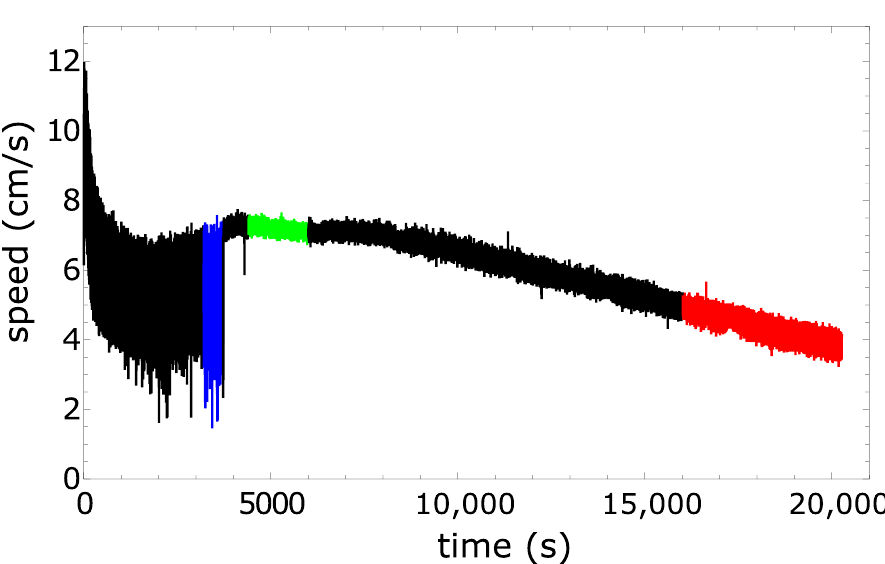
Figure 15. The speed of a 10% polypropylene, 45% camphene, and 45% camphor weight mixture as a function of time obtained from the trajectory illustrated in Figure 14a. The colored parts of the plot correspond to the modes of motion illustrated in Figure